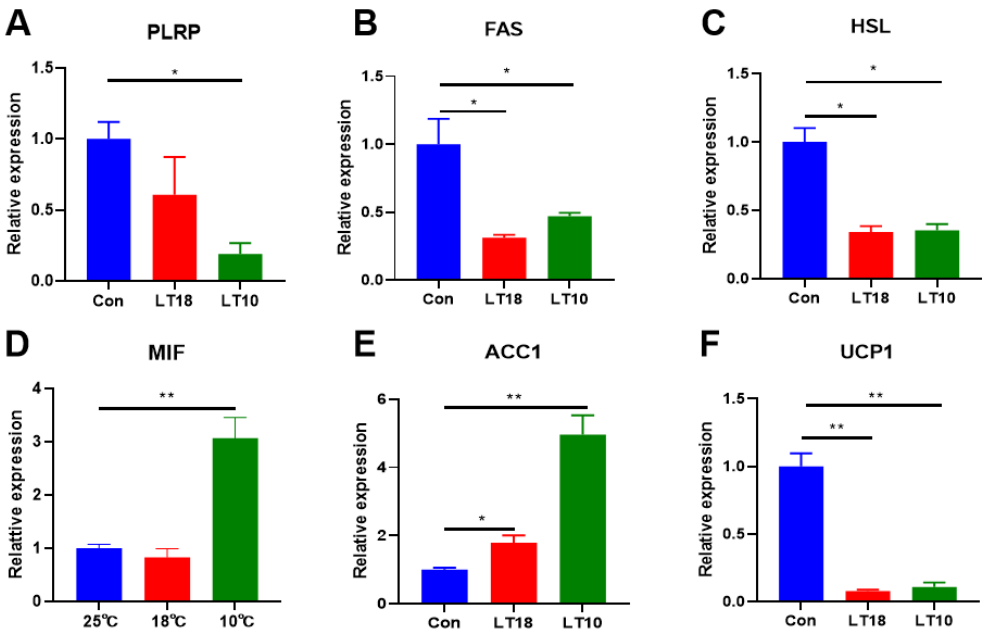
Figure 4. Expression of the lipid metabolism-related key genes in freshwater drums liver induced by 2 days cold stress ( n = 9): ( A ) pancreatic lipase-related proteins, PLRP; ( B ) fatty acid synthesis, FAS; ( C ) hormone-sensitive lipase, HSL; ( D ) cytokine macrophage migration inhibitory factor, MIF; ( E ) acetyl Coenzyme A Carboxylase 1, ACC1; ( F ) uncoupling protein 1, UCP1. Asterisk represents the statistical difference (*, p < 0.05; **, p < 0.01).